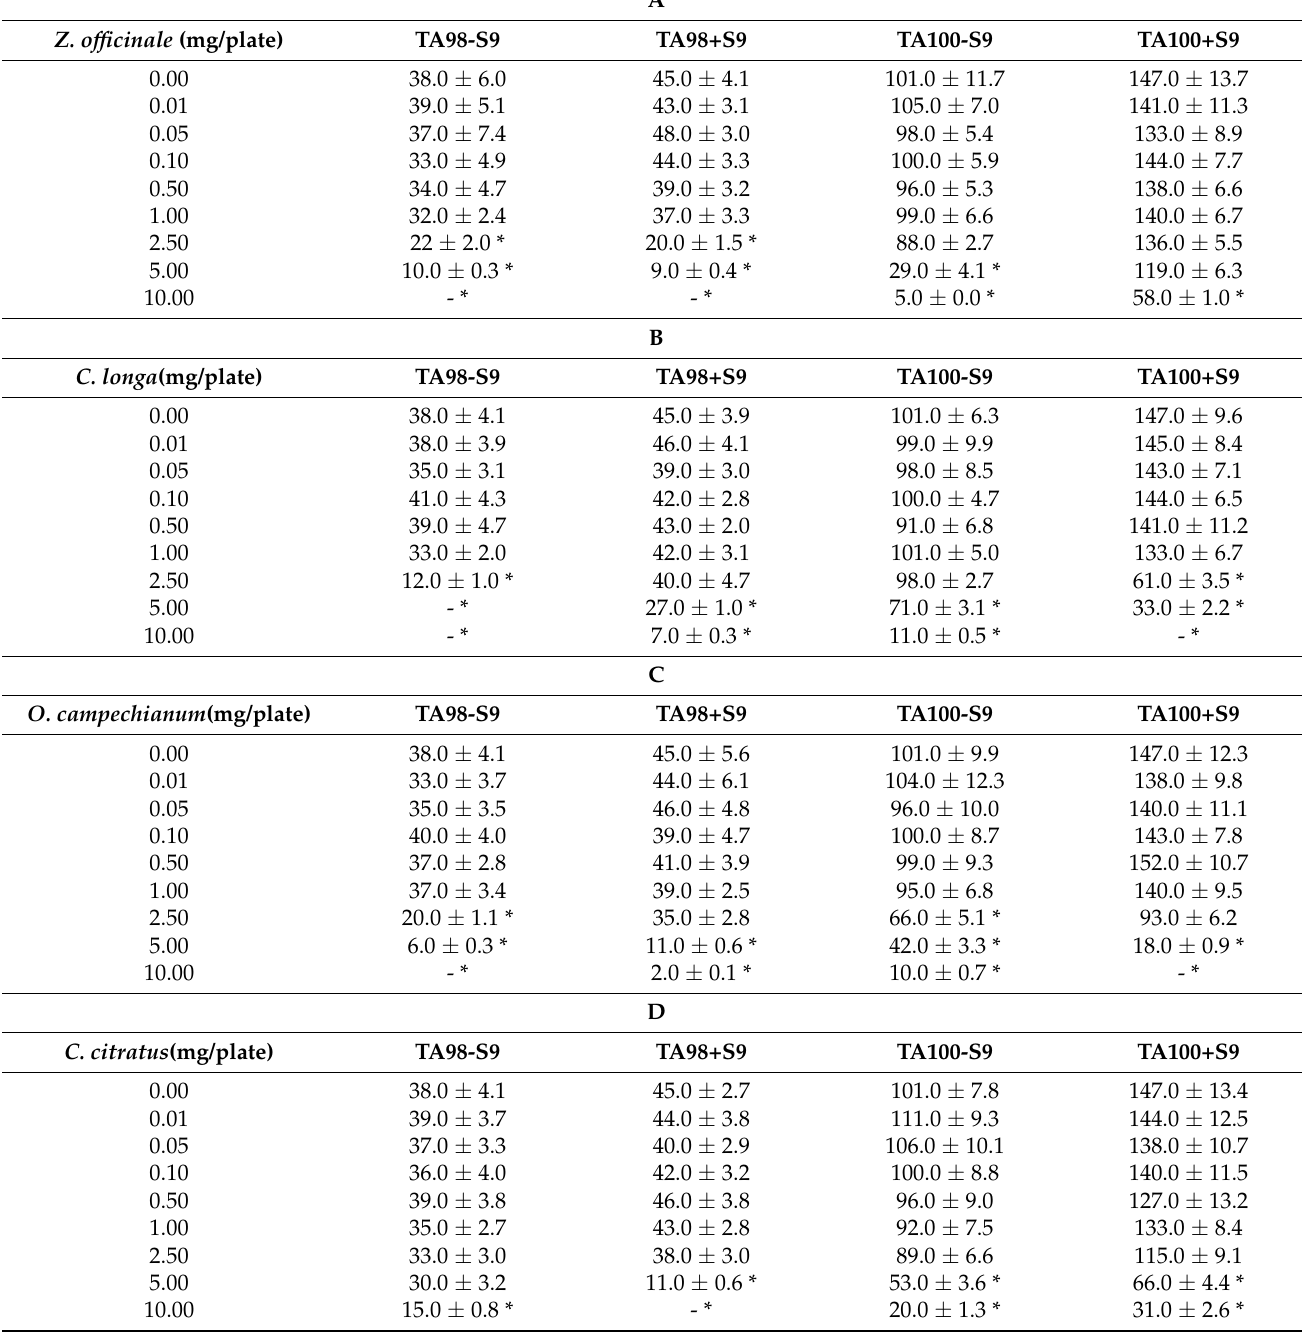
Table 6. ( A – D ). Highest Uneffective Dose (HUD) tested with and without metabolic activation (S9 mix). HUD represents the maximum concentration of EOs DMSO diluted which does not induce cytotoxic evidence in S. typhimurium TA98 and TA100 strains cultures. The HUD data are essential to interpret the results of a significant decrease in the number of Salmonella revertants in anti-genotoxic assays. Negative controls (EO = 0.000 mg/plate) were set up with 100 mL/plate of DMSO. The results are expressed both as survival percentage ± standard deviation (s.d.) and Colony Forming Units (CFU)/plate ± standard deviation. Table 6A: Zingiber officinale EO cytotoxicity; Table 6B: Curcuma longa EO cytotoxicity; Table 6C: Ocimum campechianum EO cytotoxicity; Table 6D: Cymbopogon citratus EO